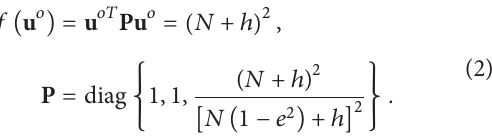
Figure 1: Target geolocation